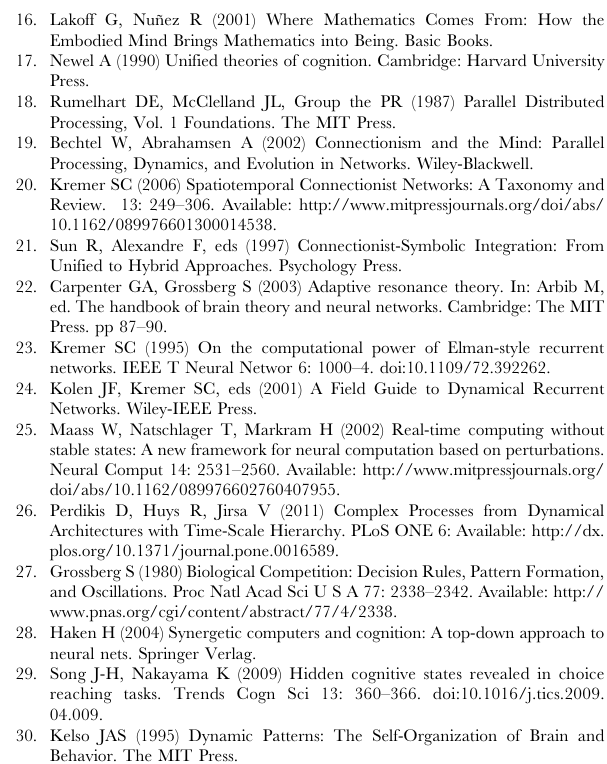
Figure S7 Phase space analysis for a non-autonomous slow operational signal and for s = 0.01. Figure notation